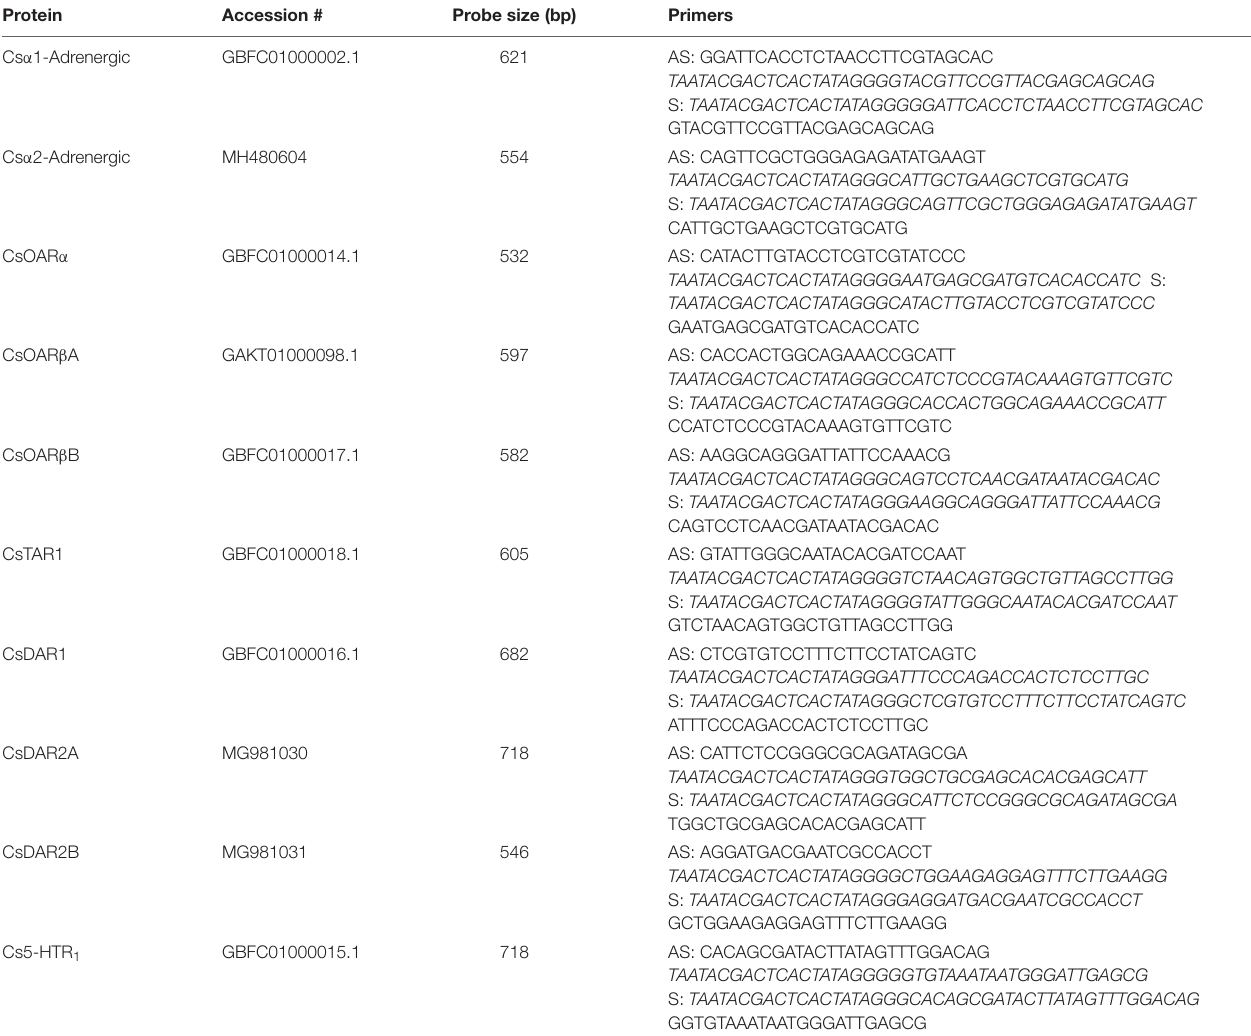
TABLE 1 | Cupiennius salei biogenic amine receptor nomenclature and primer sequences used for RNA probes for in situ